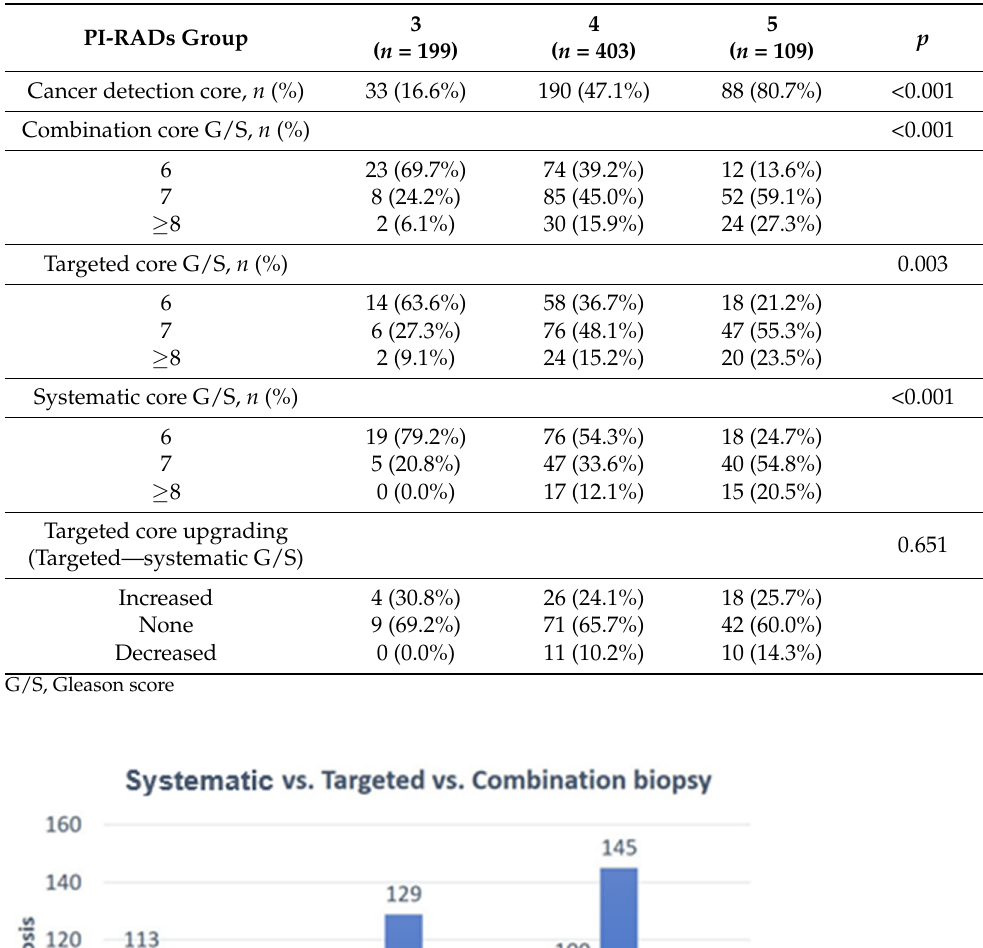
Figure 2. Cancer diagnosis core number in the initial and repeat biopsy settings.